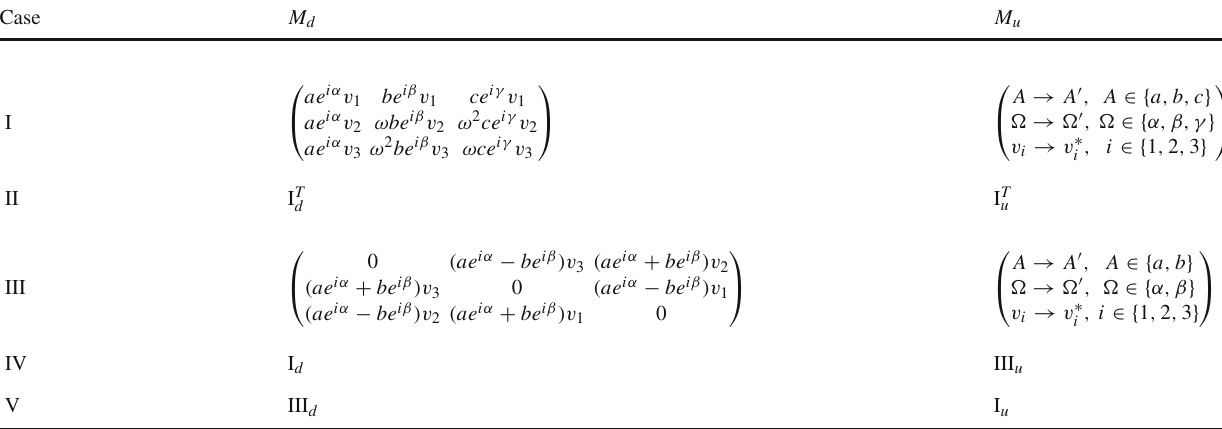
Table 1 Extensions of A 4 to the Yukawa sector with non-vanishing determinant, and non-zero J for general, complex valued, vevs (v 1 ,v 2 ,v 3 ) . In the table, I d stands for the matrix M d for case I and similarly for the other entries Case M